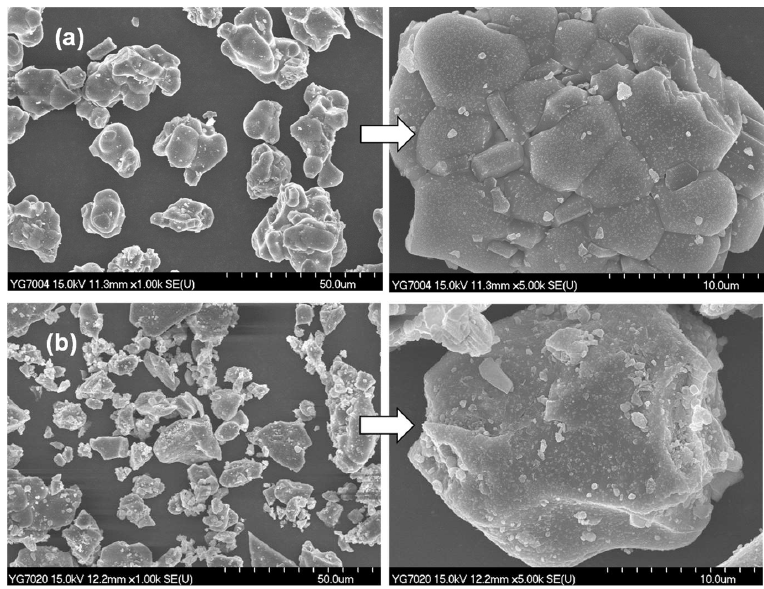
Figure 2. Scanning electron microscopy (SEM) images of SAOs synthesized by ( a ) hydrothermal reaction and ( b ) sol–gel method.